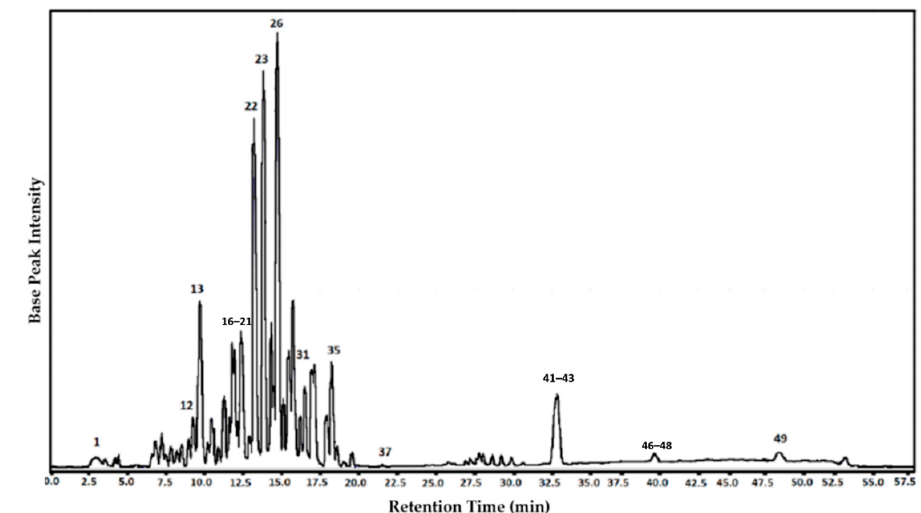
Figure 1. Chromatogram of red propolis extract (RPE) obtained using Orbitrap-coupled liquid chromatography and Fourier transform mass spectrometry (LC-Orbitrap- FTMS).